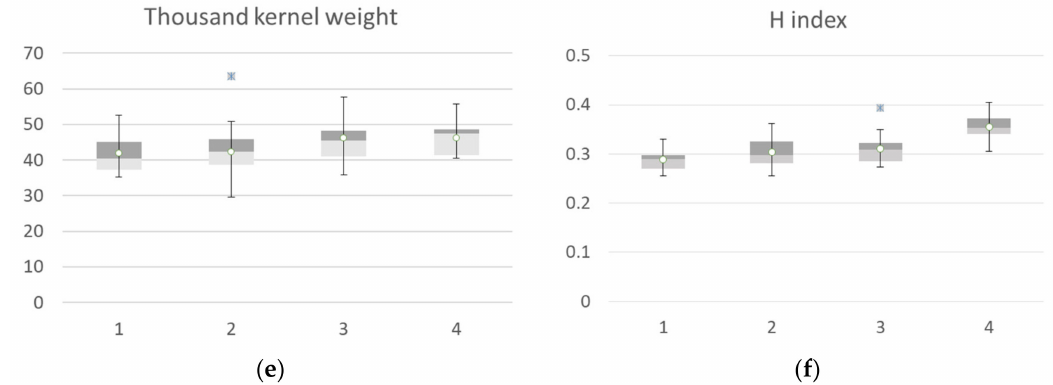
Figure 9. Box plot of Agronomic traits collected at harvest: yield ( a ), biomass ( b ), spike weight ( c ), spike numbers ( d ), thousand-kernels weight ( e ) and harvest index ( f ) of the seven durum wheat cultivars grouped according to the 4 identified VI clusters at flowering. All the components showed a significative difference among clusters, while thousand kernel weight showed no significant differences among cluster (Kruskal–Wallis